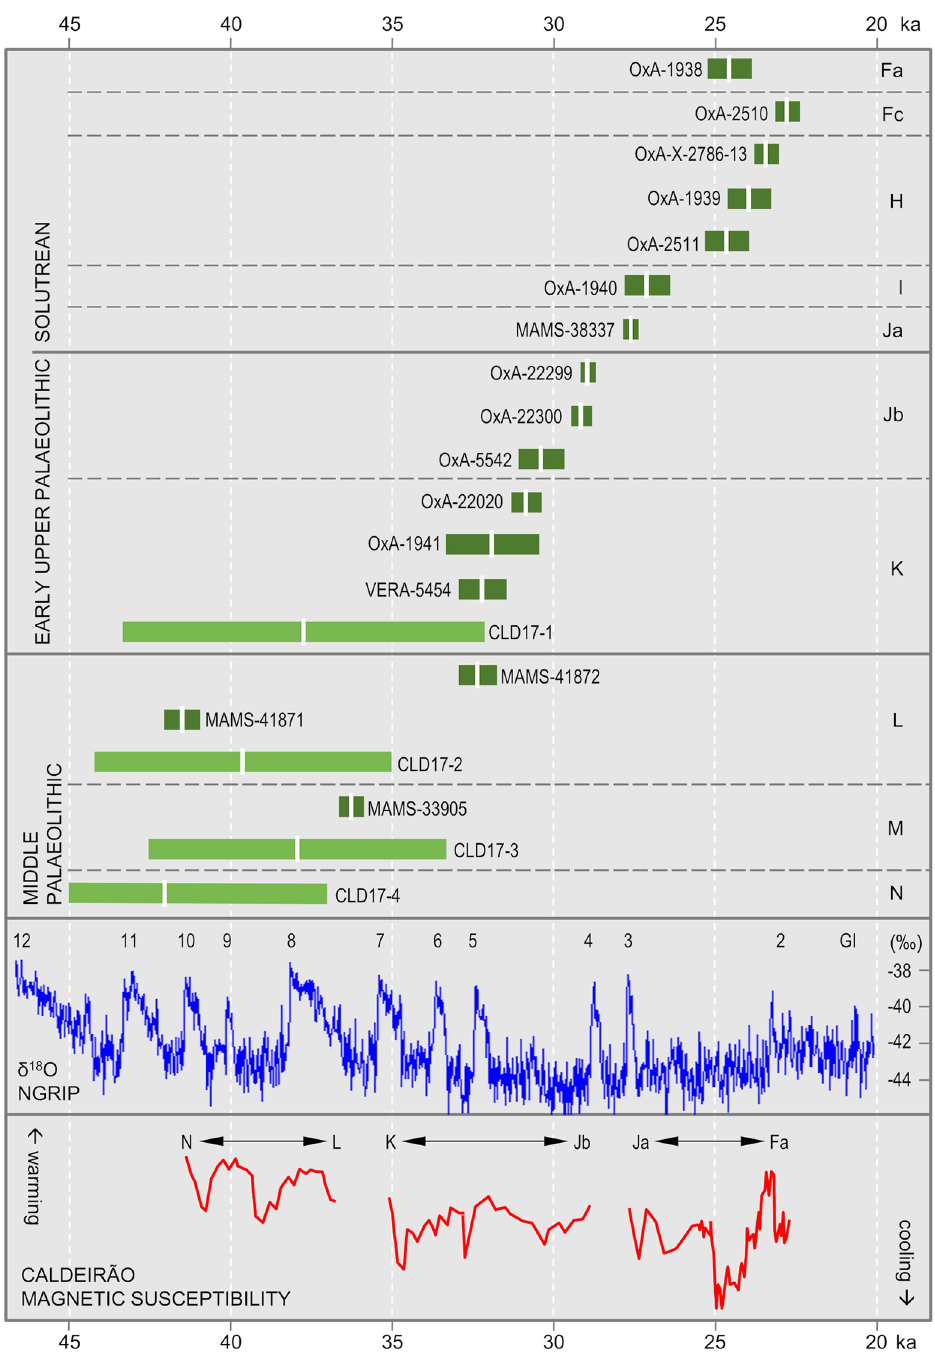
Fig 23. Chronology and palaeoenvironmental context of the transition at Gruta do Caldeir ã o (back chamber). The bars indicate the 95.4% probability intervals of the calendar ages in Tables 5 and 6. OxA-37728 and OxA-37729 (which date intrusive human bone from the overlying Cardial context), OxA-5521, OxA-5541 and OxA-8670 (which reflect incomplete decontamination and are minimum ages only), and OxA-22301 (which is from a subfossil marine shell) have been excluded. Plotting of the NGRIP climate curve used CalPal (version 2017.5) [83]. The magnetic susceptibility curve is from Fig 6A, here sectioned into segments whose length has been adjusted to account for the hiatuses and the